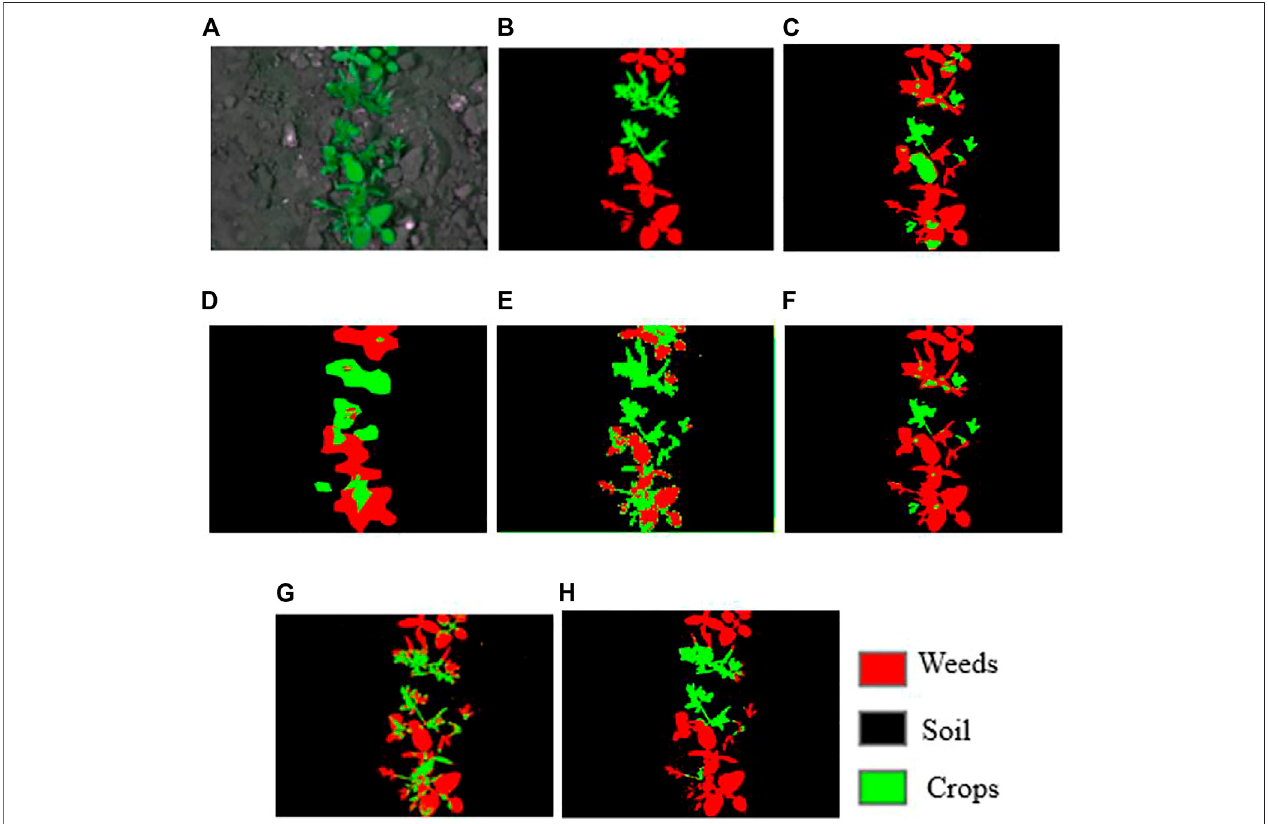
FIGURE7| SamplequalitativeresultswereachievedforCWFID. (A) inputimages; (B) groundtruth, (C) SegNet, (D) FCN-32s, (E) FCN-16s, (F) FCN-8s, (G) U-Net, (H) DeepLabV3++.